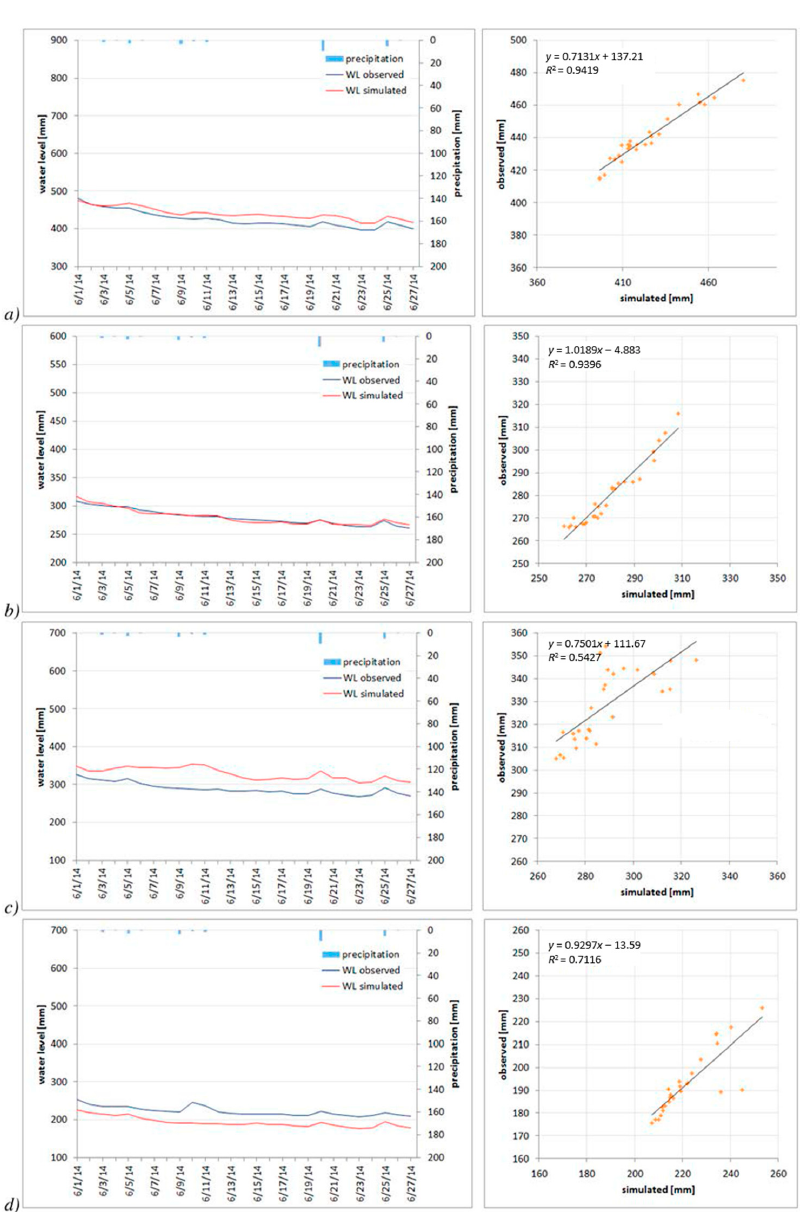
Figure 11. Simulation scenario SC5—low flow period of 1 June–27 June 2014 at stations: ( a ) RKM; ( b ) JAV; ( c ) ROK; and ( d ) HAJ.